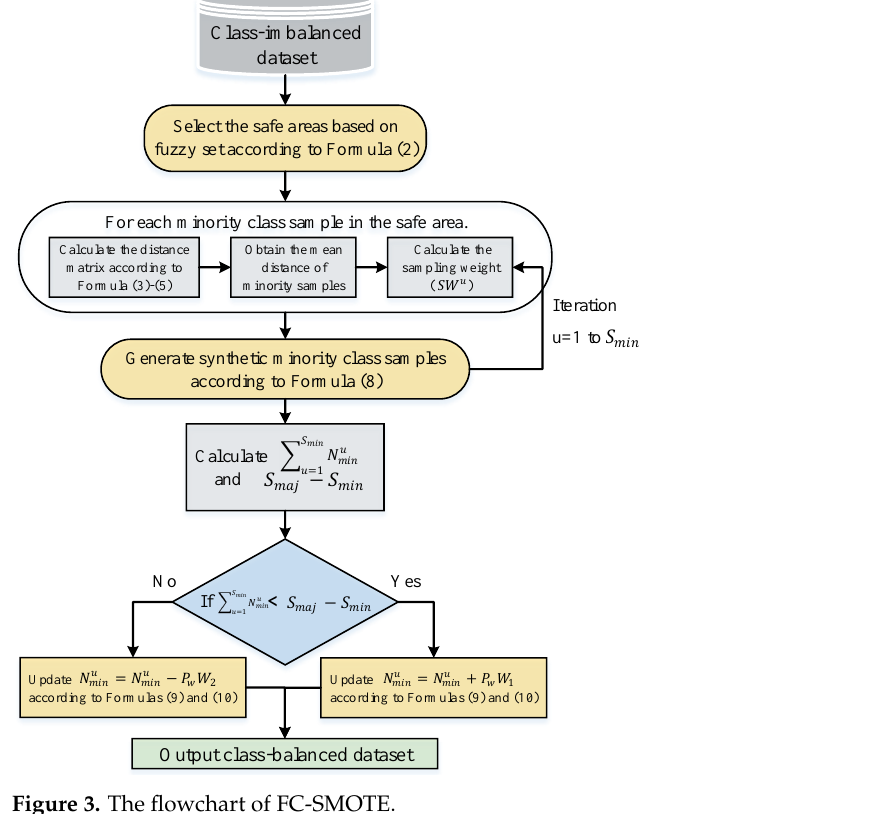
Figure 3. The flowchart of FC-SMOTE. Algorithm 1 The algorithm of the